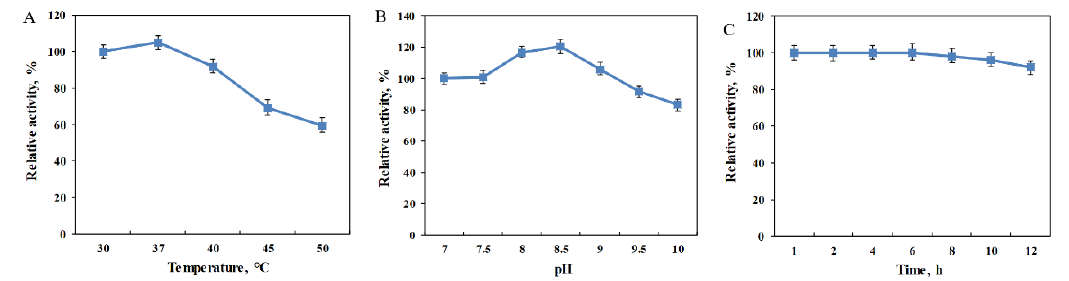
Figure 3. The effect of pH, temperature and storage time on the activity of the purified MBP-PmLAAD fusion enzyme. ( A ) The effect of temperature on fusion enzyme activity. ( B ) The effect of pH on fusion enzyme activity. ( C ) The stability of the purified MBP-PmLAAD.